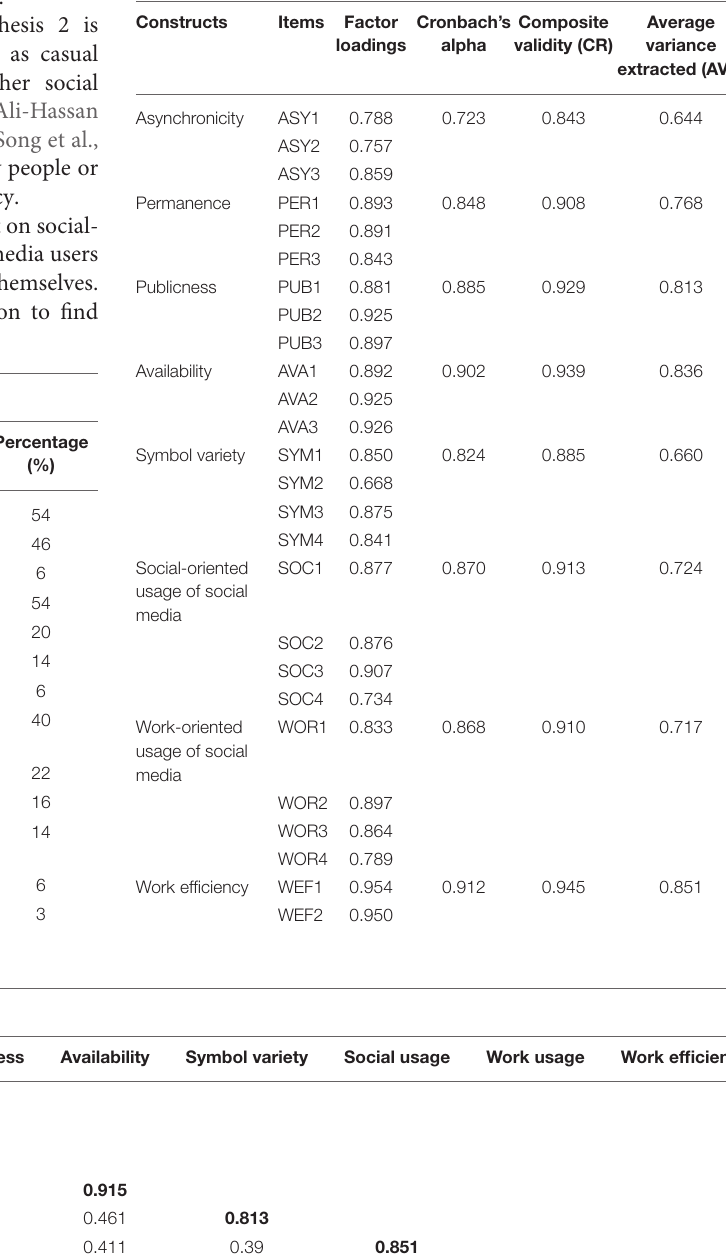
TABLE 2 | Reliability tests for constructs and items.